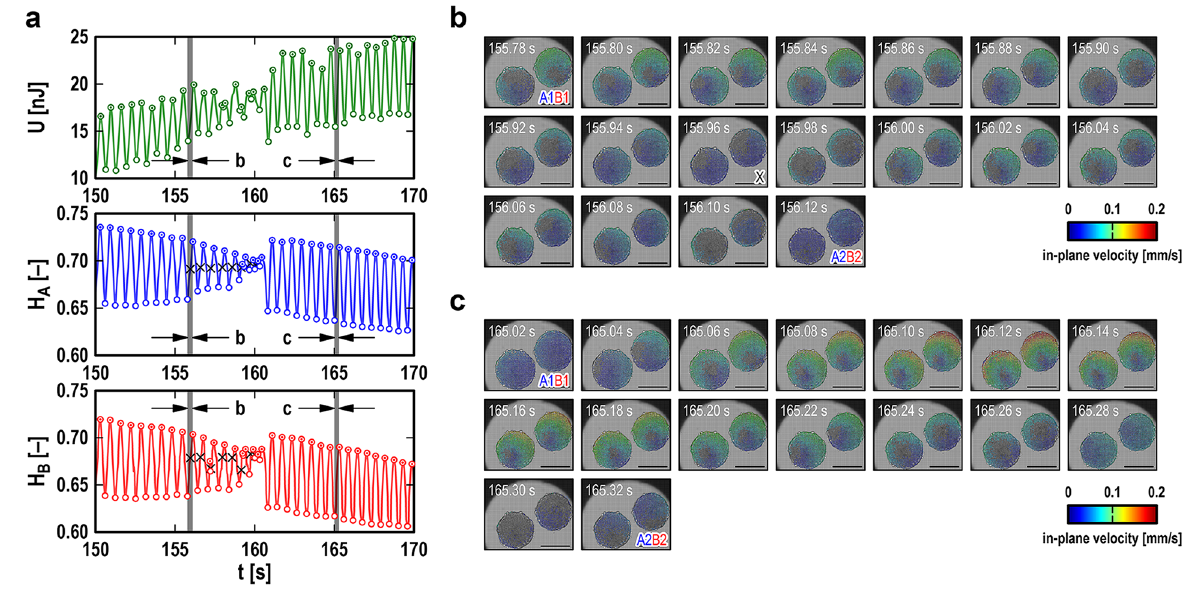
Figure 5. The temporary arrest of synchronous beating and its precursors in a pair of cardiac spheroids (CSs) under compression. ( a ) Temporal changes in the potential energy of the probe, U (top graph), and the normalized heights of the CSs, H A (middle graph; for the left CS in the snapshots in b and c ) and H B (bottom graph; for the right CS in the snapshots in b and c ), in the range of t = 150–170 s (from Figs. 4c and 4d). The open and dotted circles represent the local minimum (i.e., CS pair relaxation) and local maximum (i.e., CS pair contraction), respectively. The cross symbols represent the precursors of the temporary arrest (at t ~ 160 s) of synchronous beating. ( b ) Snapshots of the CSs in the range of t = 155.78–156.12 s. c : Snapshots of the CSs in the range of t = 165.02–165.32 s. The colors of the CSs in ( b ) and ( c ) represent the local in-plane velocity of the CSs calculated by particle image velocimetry. A1 and B1 are snapshots at the local minima of H A and H B , respectively, and A2 and B2 represent the local maxima of H A and H B , respectively. The snapshot at t = 155.96 s marked by X in ( b ) is an example of the precursors (i.e., the momentary arrest of the CS pair for less than 40 ms). The scale bar in each snapshot represents 0.3